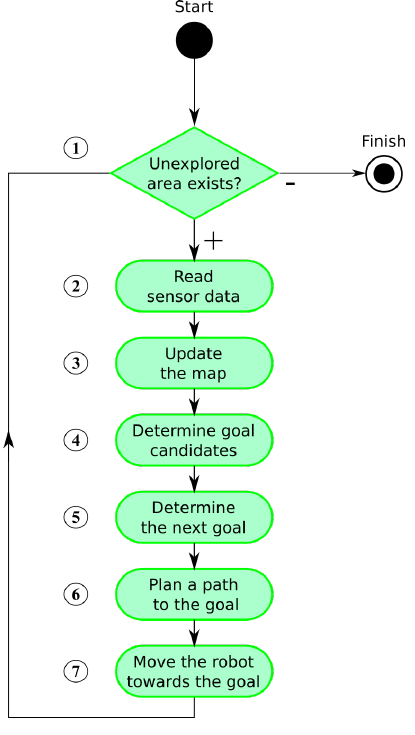
Figure 1. The exploration